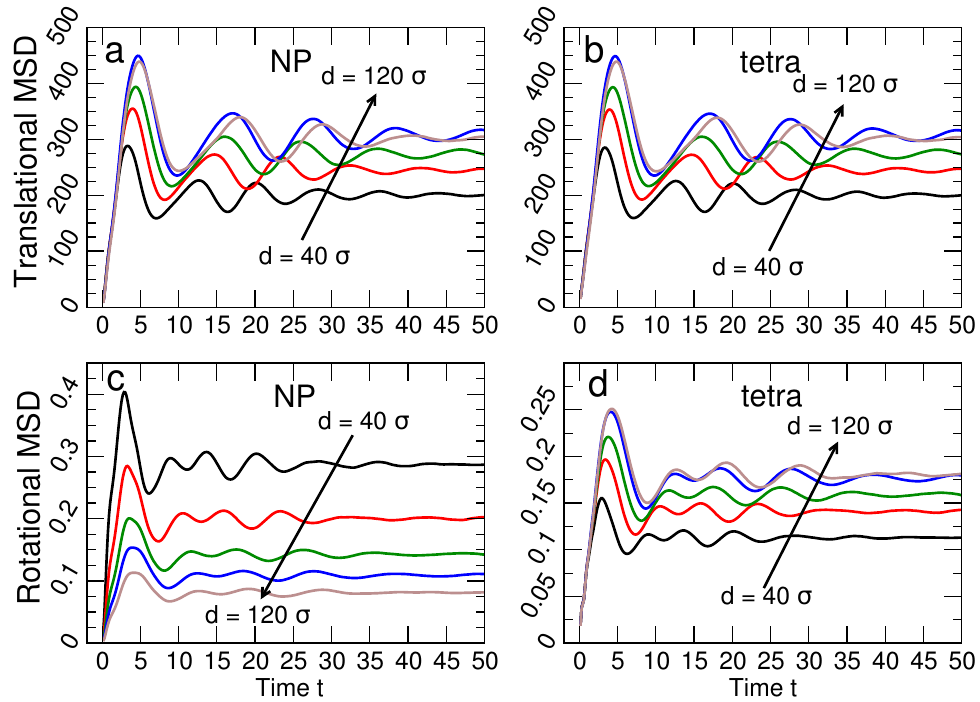
Figure 7. The time dependence of the translational and rotational vibration of the tetrahedral cages and NPs. The translational mean-squared displacement (cid:104) r 2 ( t ) (cid:105) for ( a ) NP and ( b ) tetrahedra are very similar; the saturation value (cid:104) u 2 (cid:105) of the MSD increases for both NP and tetrahedra with increasing NP size. The rotational mean-squared displacement (cid:104) θ 2 ( t ) (cid:105) for ( c ) NP and ( d ) tetrahedra differ significantly. Specifically, the saturation value (cid:104) φ 2 (cid:105) for NP decreases as the NP size increases, while (cid:104) φ 2 ( t ) (cid:105) for tetrahedral cages increases as the NP size increases. Note that dependence on NP size of the rotational MSD of NPs is different than the other three MSDs. All data are for the system with stiffness k a = 1.0. The black, red, green, blue and brown lines correspond to d = 40,60,80,100,120 σ ,